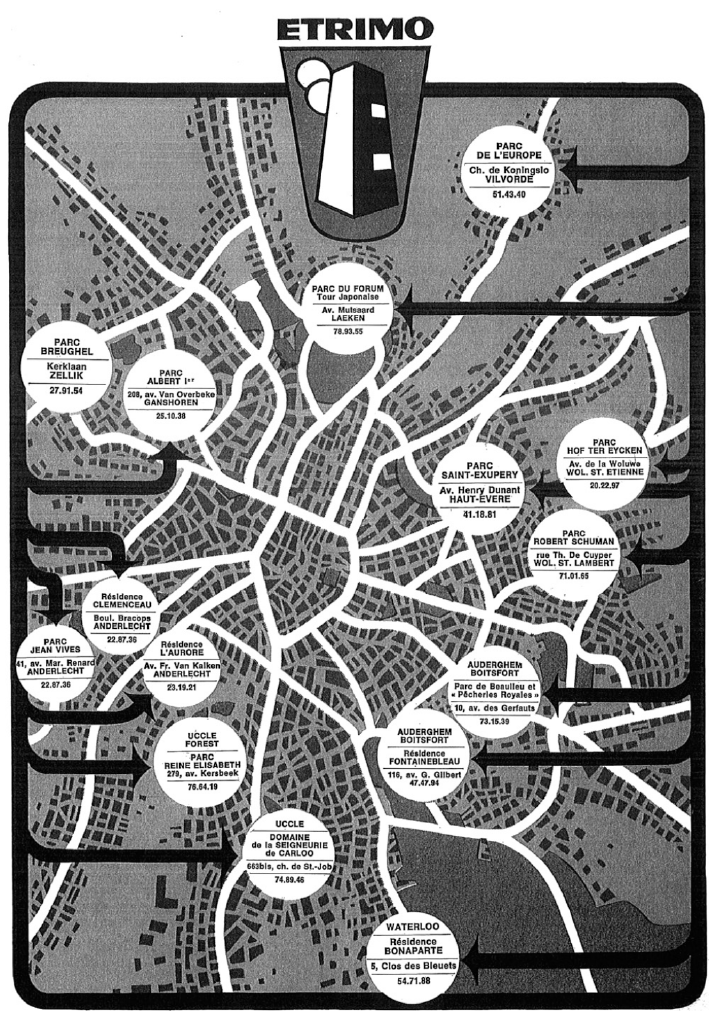
Figure 6. Etrimo, Sales brochure , 1960s. Source: courtesy of Pol Mertens, a former Etrimo administrator. lack of economic means and political support that re- strained its interbellum implementation. In Brussels, the modernist rhetoric was called upon to (re)construct the city after the war, affecting its territory in terms of urban planning and housing. However, the tangible projects dif- fer from the initial